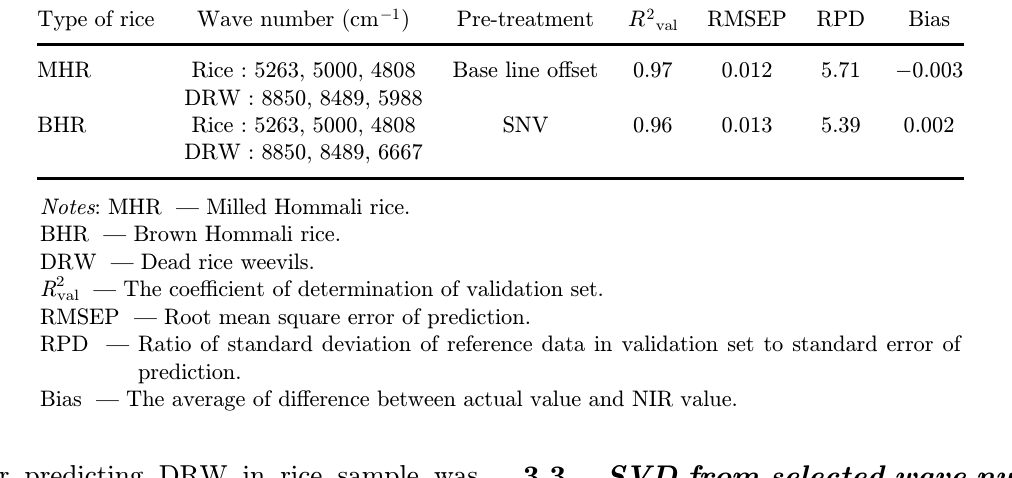
Table 5. Statistics of prediction of DRW (%) in MHR and BHR by SVD model. Type of